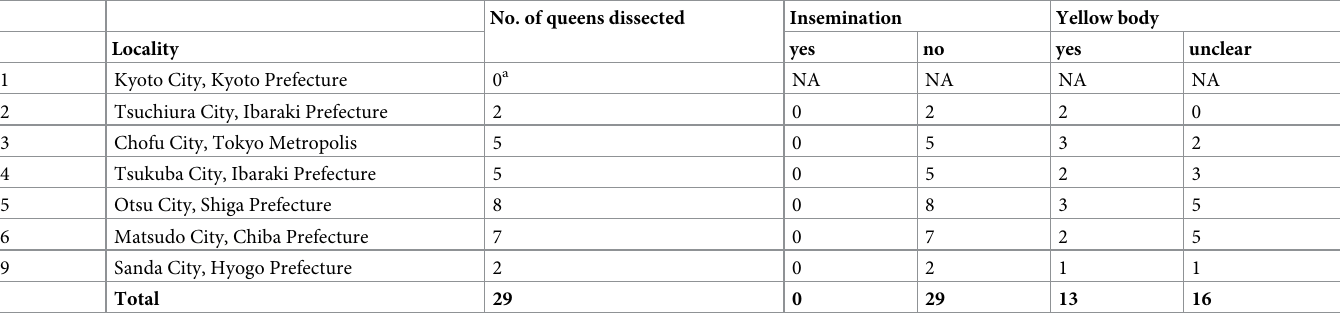
Table 4. Dissection of virgin queens from the rearing experiment.